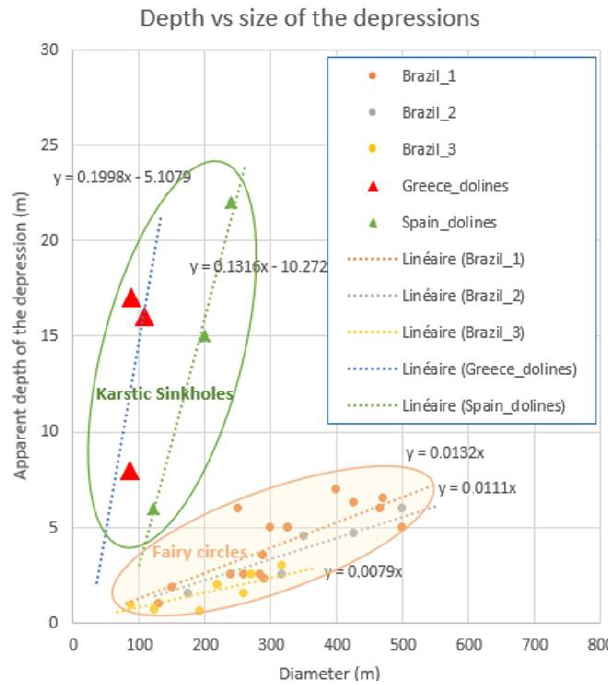
Figure 8. Relationship between size and depth for the studied fairy circles and for dolines from Greece and Spain. The relation size/depth is not perfect for the fairy circles but remains around 1%. This relation is different for the dolines, which range to deeper depressions.